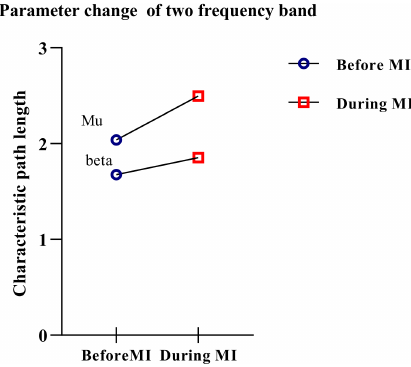
Figure 7. Variation of average characteristic path length.